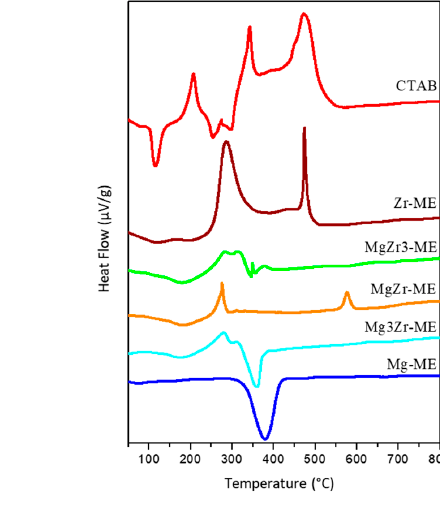
Figure 2. Differential thermal analysis (DSC) profiles obtained for the dried gels corresponding to both series of solids synthesized: ( a ) Sol-Gel and ( b ) Microemulsion.